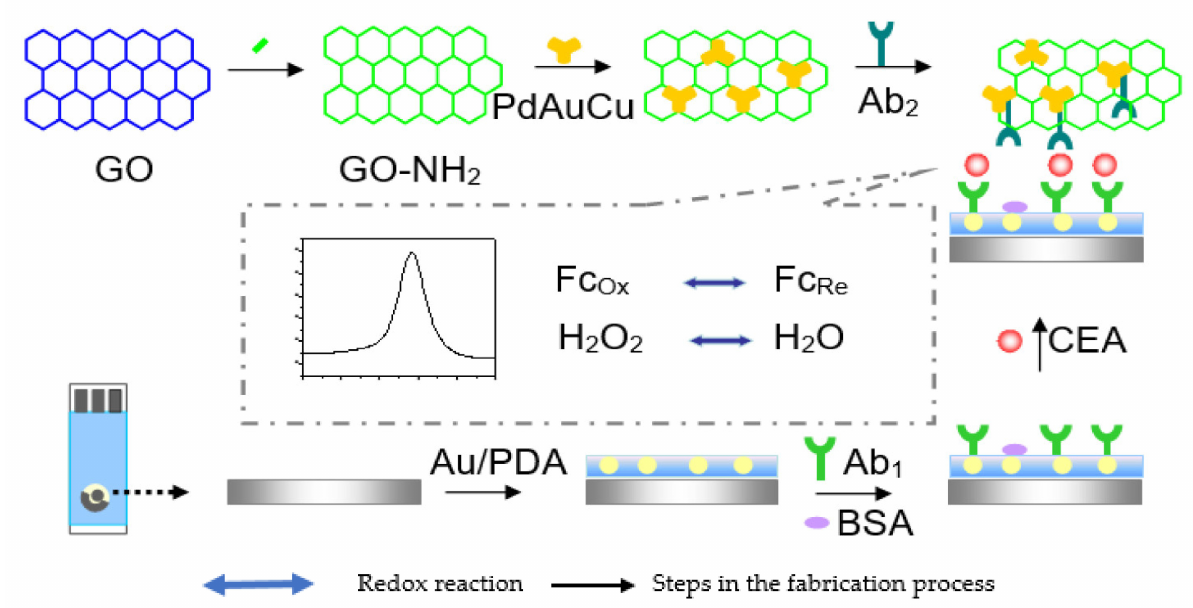
Figure 13. The schematic illustration of the fabrication procedure for CEA immunosensor.GO- NH 2 : amine–doped graphene oxide; Ab1: primary antibody; Ab2: secondary antibody; Fc: feroccene; Ox: oxidation; Re: reduction